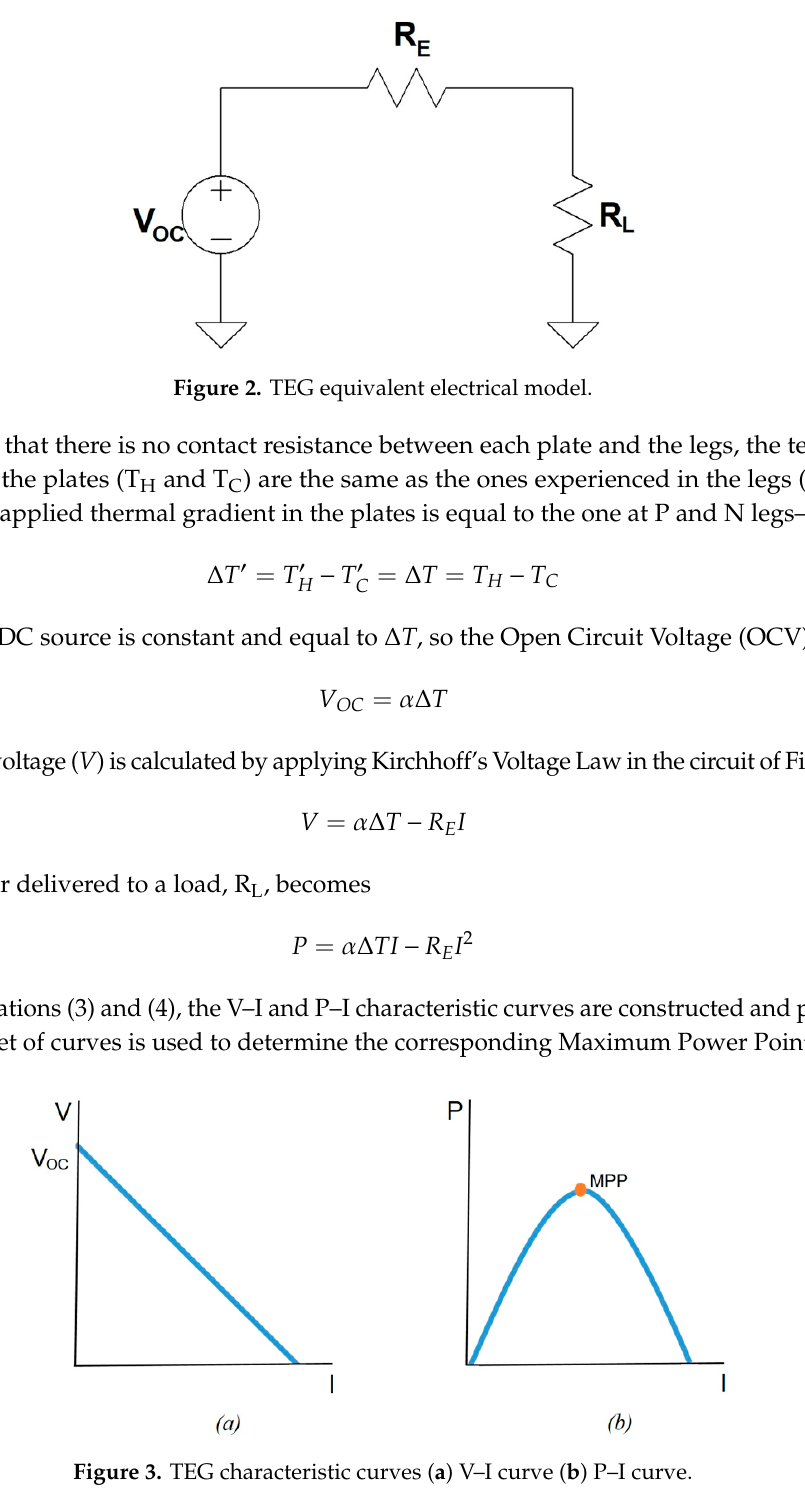
Figure 1. TEG internal components.